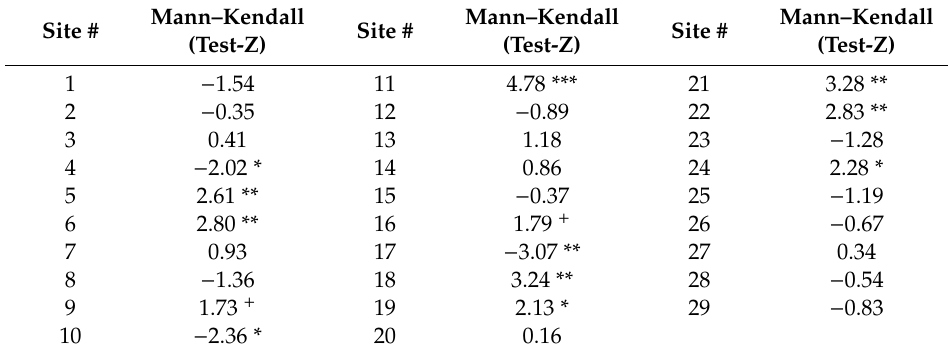
Table 2. Description of trends in the annual maximum flood regime across the KRB, Pakistan. Mann–Kendall Site # Site (Test-Z)